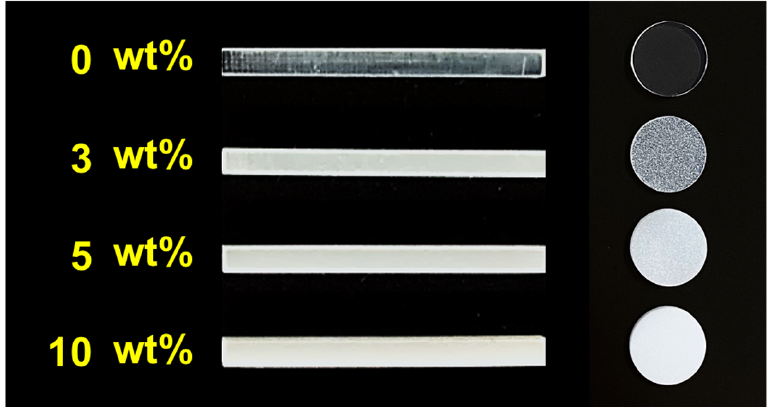
Figure 5. Finished specimens. Mass percentages of zirconia filler: 0 (control), 3, 5, and 10 wt.%. The specimen became opaque with increasing amounts of zirconia filler. This image was captured against a black background to make it easier to determine the color of the specimens.